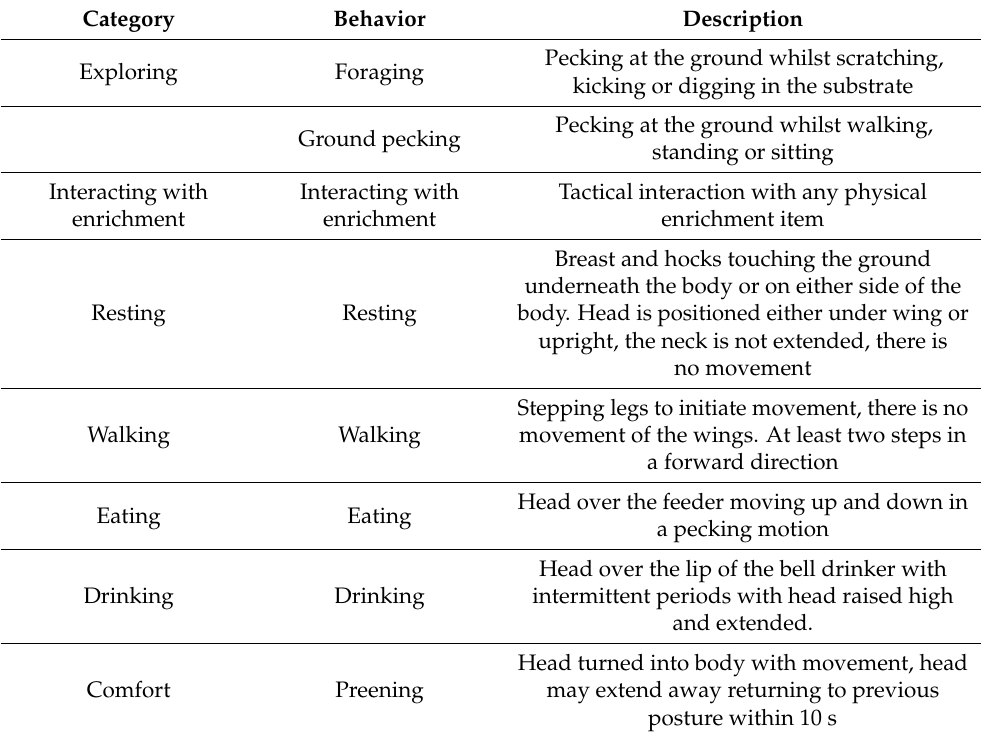
Table 1. Ethogram to assess the behavioral time budgets of meat